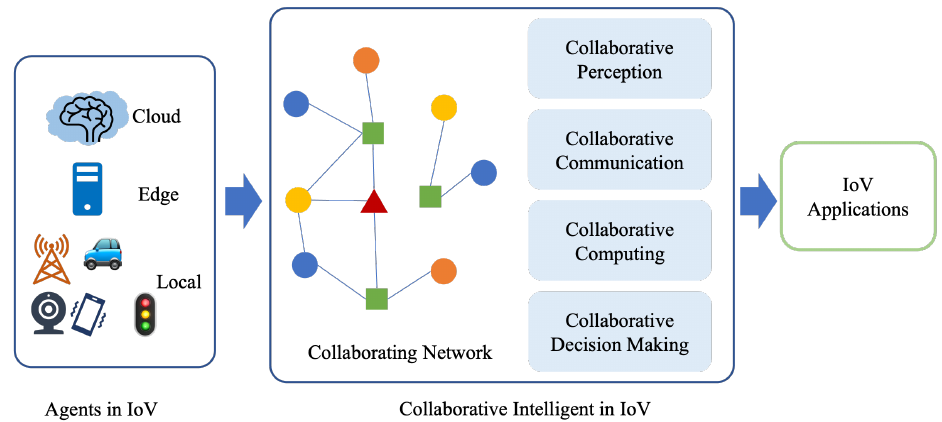
Figure 4. Collaborative Intelligence in the Internet of